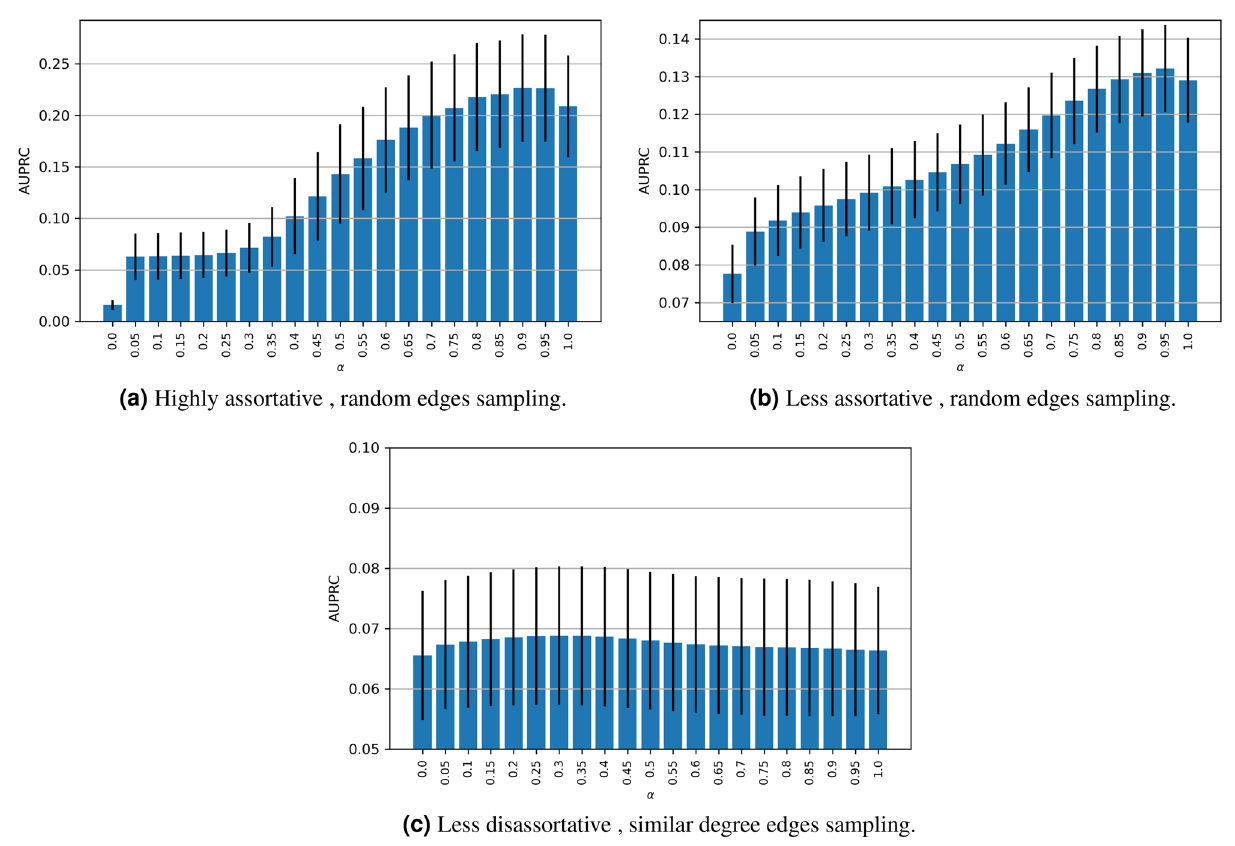
Figure 8. Exploratory analysis for α . Showing the best AUPRC performance of the contribution of both of CN CN _ inDAGI and inDAGI in ( S x , y ), used on the 100 synthetic networks (of size 250), with different weights ( α